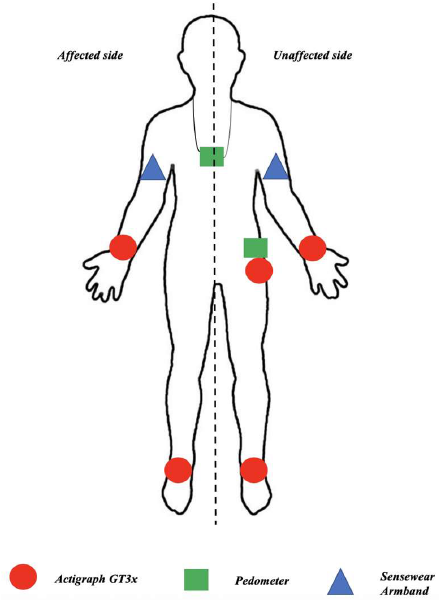
Figure 1. Placement of the devices.